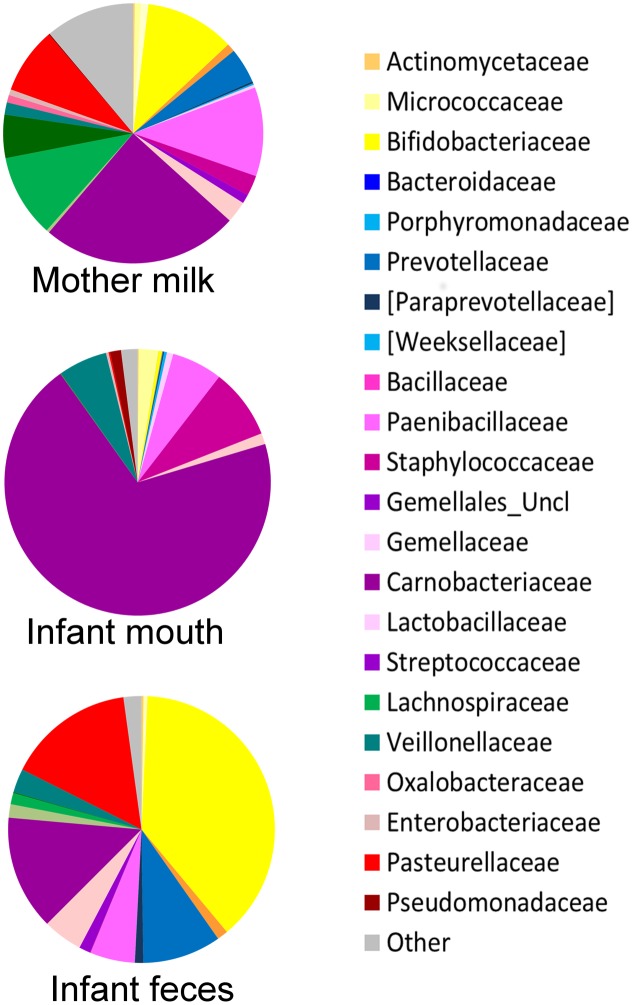
Average composition of the bacterial community in mother’s milk and infant’s mouth and feces. For each group of samples, a pie chart based on the average relative abundance (%) at family level is plotted. Bacterial families with relative abundance ≥0.2% in at least 10% of the samples are depicted. Colors for each family are reported in the legend.